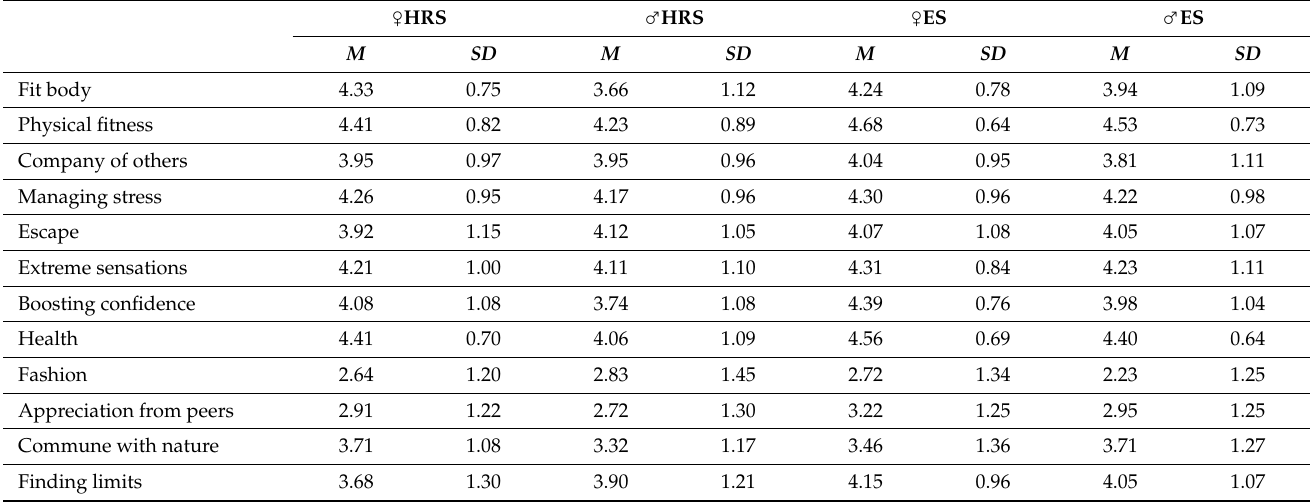
Table 4. Summary of regression analysis: importance of goals and satisfaction with